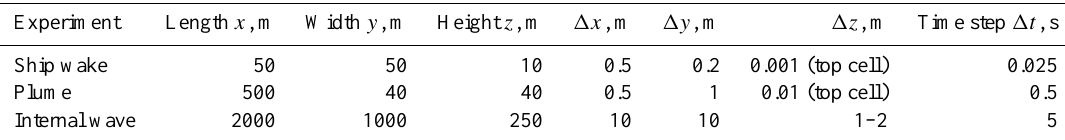
Table 2. Grid dimensions and time steps for ship wake, low-density plume and internal wave simulations. The vertical resolution for the ship wake and plume model is highest near the top of the domain and decreases towards the bottom. For the internal wave model, the highest vertical resolution is in the thermocline.